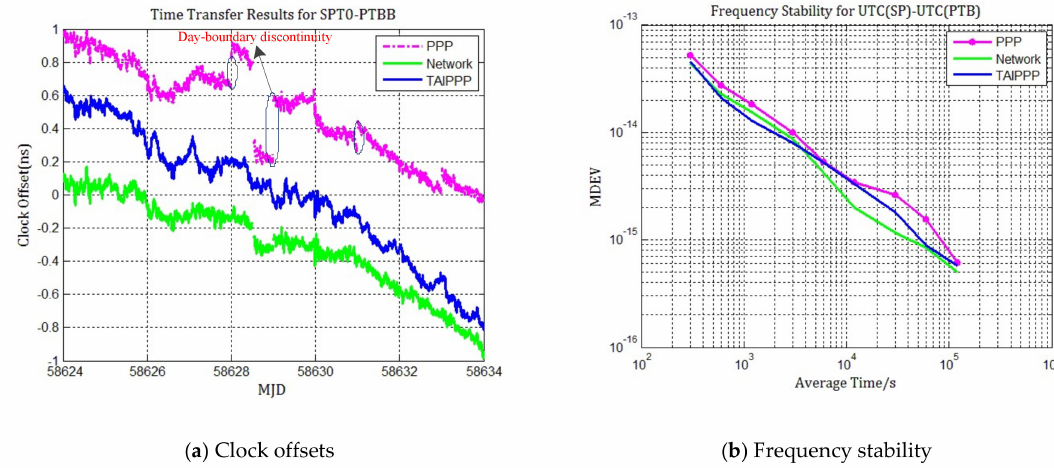
Figure 3. Time transfer and frequency stability results for UTC (SP)-UTC (PTB). ( a ) Station clock o ff sets of PPP (purple), network solution (green) and TAIPPP (blue), for MJD 58624–58633; ( b )Frequency stability for PPP (purple), network solution (green) and TAIPPP